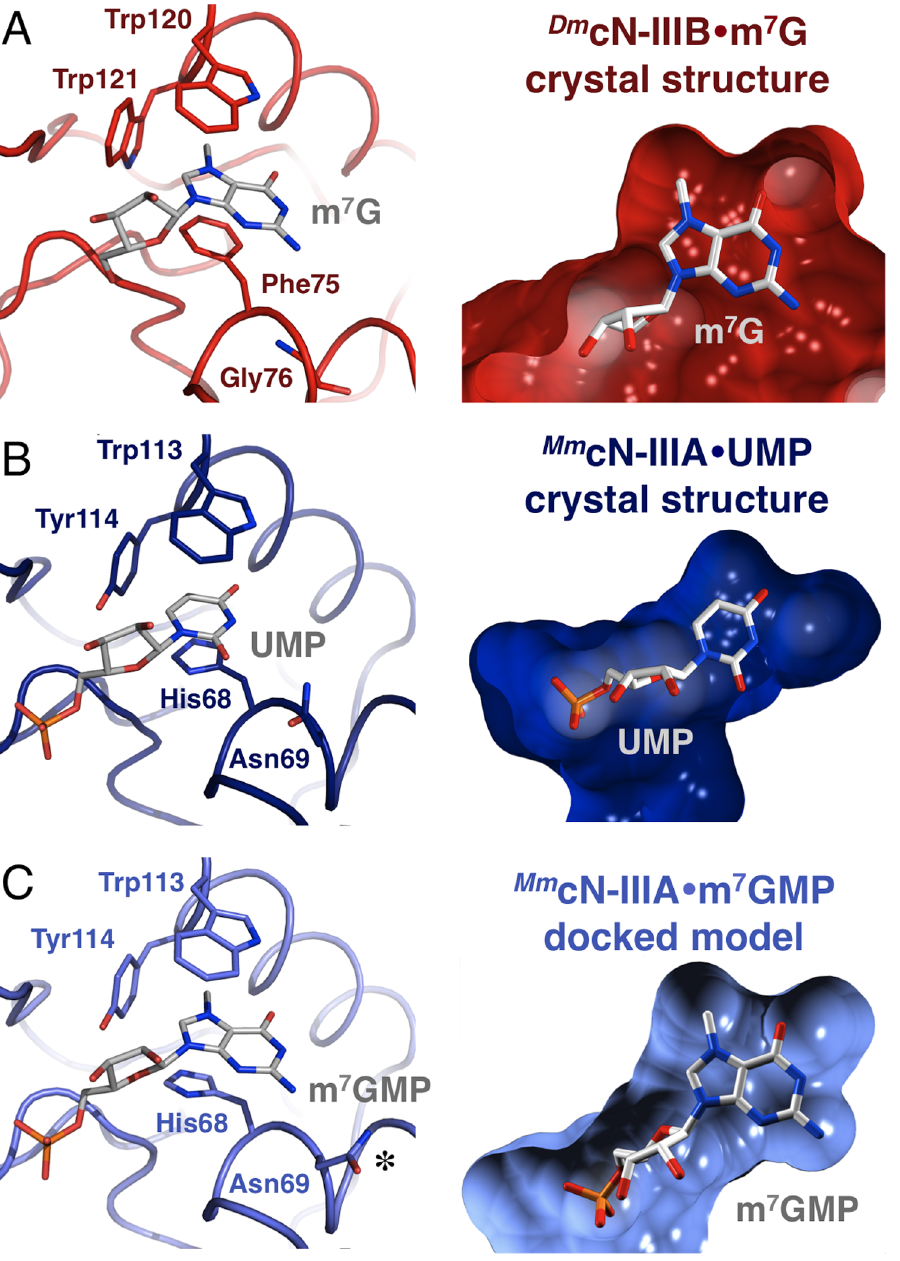
Figure 5. Structural comparison of Dm cN-IIIB and Mm cN-IIIA. Detail view on the substrate-binding pockets of Dm cN-IIIB bound to m 7 guanosine in red (A) and Mm cN-IIIA bound to UMP in dark blue (B). The left panel shows the binding pocket with labeled residues and substrates represented as sticks. Note that Phe75 of Dm cN-IIIB is replaced by a histidine in Hs cN-IIIA while the Trp121 of Dm cN-IIIB is replaced by a tyrosine in Hs cN-IIIA. In the right panel the substrate-binding pockets are shown as surfaces, which were calculated using a probe radius of 1.65 A˚ and for clarity reasons were clipped at the level of the nucleobases. Note that the substrate-binding pocket for m 7 G (cN-IIIB, red surface) is significantly larger than the UMP binding pocket of cN-IIIA (blue surface), which was thought to be the structural reason for its purine substrate exclusion. (C) Orientation of substrate binding residues and the corresponding pocket after docking m 7 GMP to Mm cN-IIIA (light blue). Note that Asn69 (marked by an asterisk) rotates by 180 degrees in comparison to (B) and adopts another common rotamer thus enlarging the binding pocket and neatly accommodating the m 7 GMP. IIIA corresponds to Gly76 in Dm cN-IIIB, and the amino acids of Hs cN-IIIA corresponding to the FGWW motif were abbreviated HNWY (His68-Asn69-Trp113-Tyr114). When Gly76 of the Drosophila enzyme was replaced by an asparagine (variant FNWW), the specificity constants for CMP and m 7 GMP changed very little,